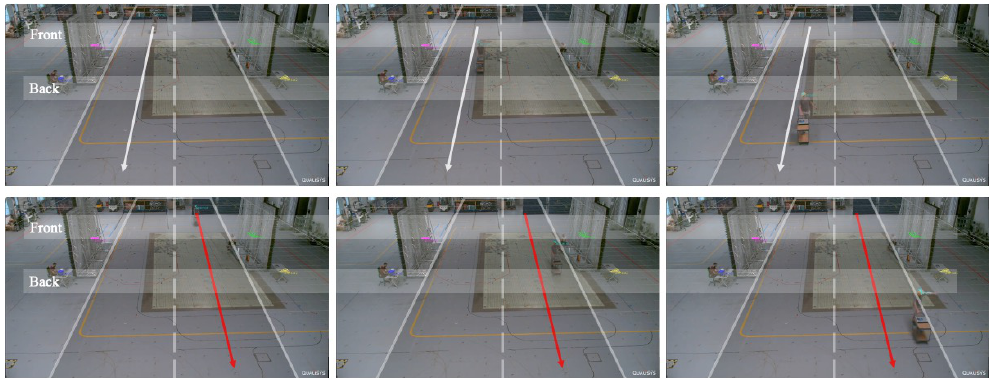
Figure 20. Lane detection experiment with four sensor nodes mounted on each side of a bridge crossing (two walls reflecting inside and absorbing outside) on a highway.